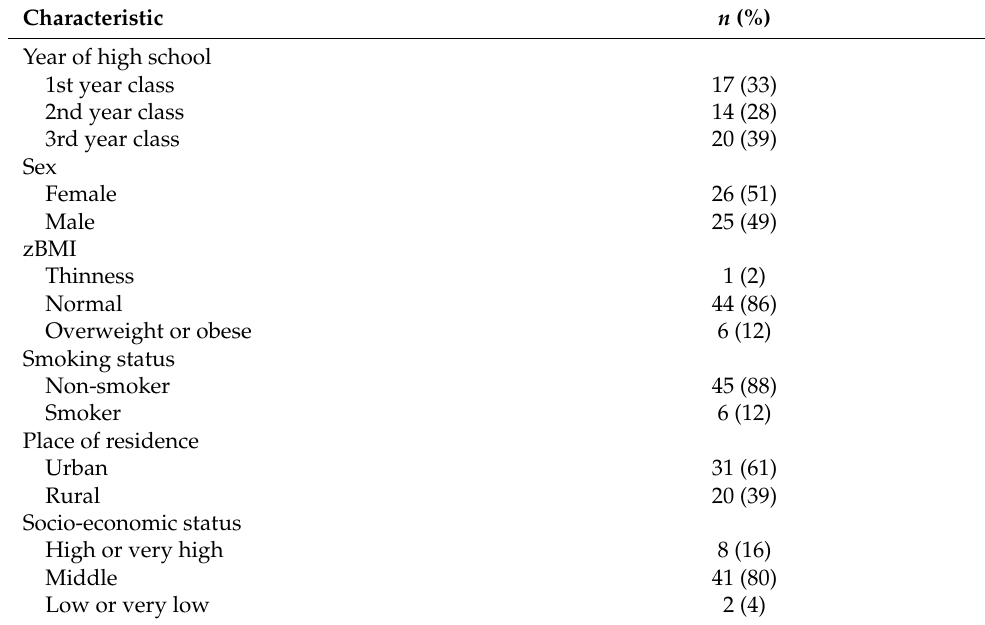
Table 1. Participant characteristics ( n = 51).